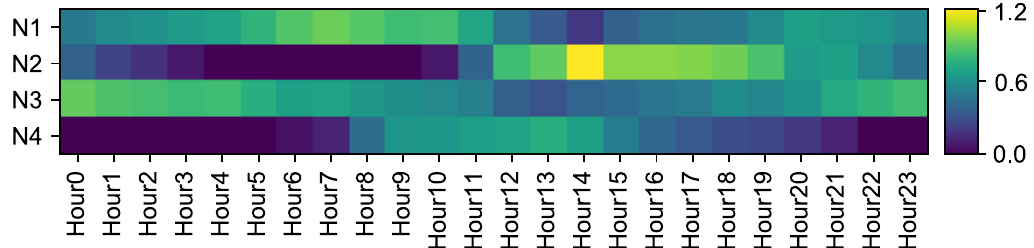
Figure 10. Heatmap showing the weights of the transpose